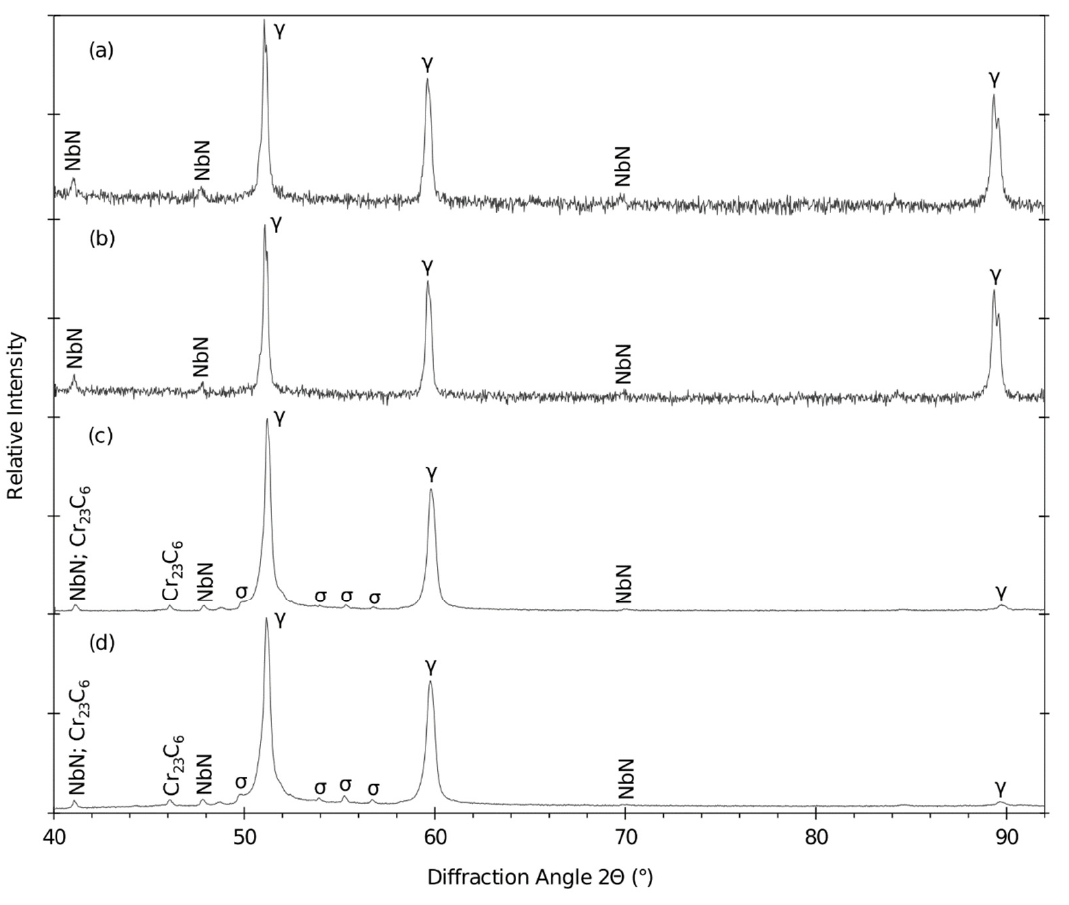
Figure 19. Diffraction patterns of the bends ( a ) in the annealed state (A), ( b ) and not annealed state (N), ( c ) nonannealed after 650 °C/7,560 h and ( d ) nonannealed after 650 °C/15,000 h.